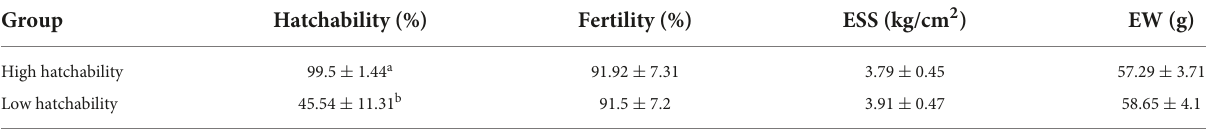
TABLE 1 Hatchability, fertility, eggshell strength, and egg weight between high and low hatchability groups.